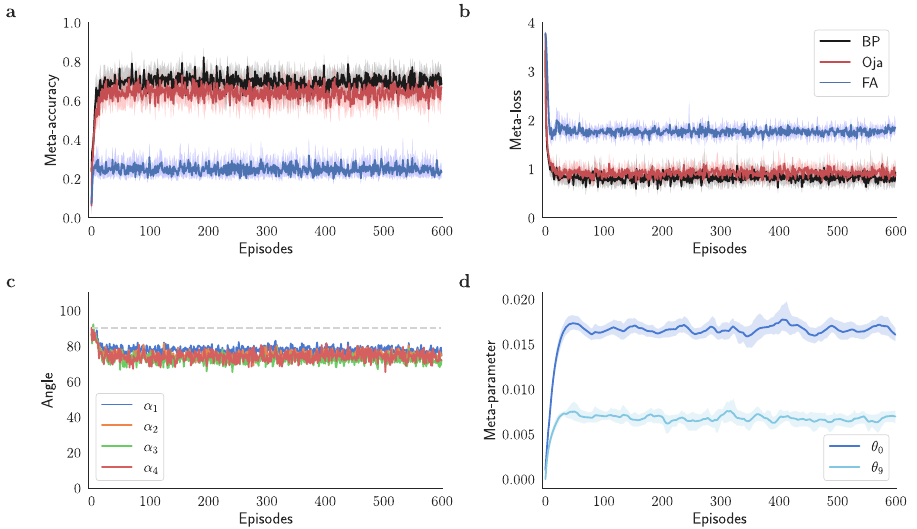
F Oja are not much backprop-like, there is still substantial improvement in the model ’ s performance, as evident in panels a and b . c Alignment angles α ℓ of modulating signals of F Oja with backprop ’ s teaching signals (in degrees).